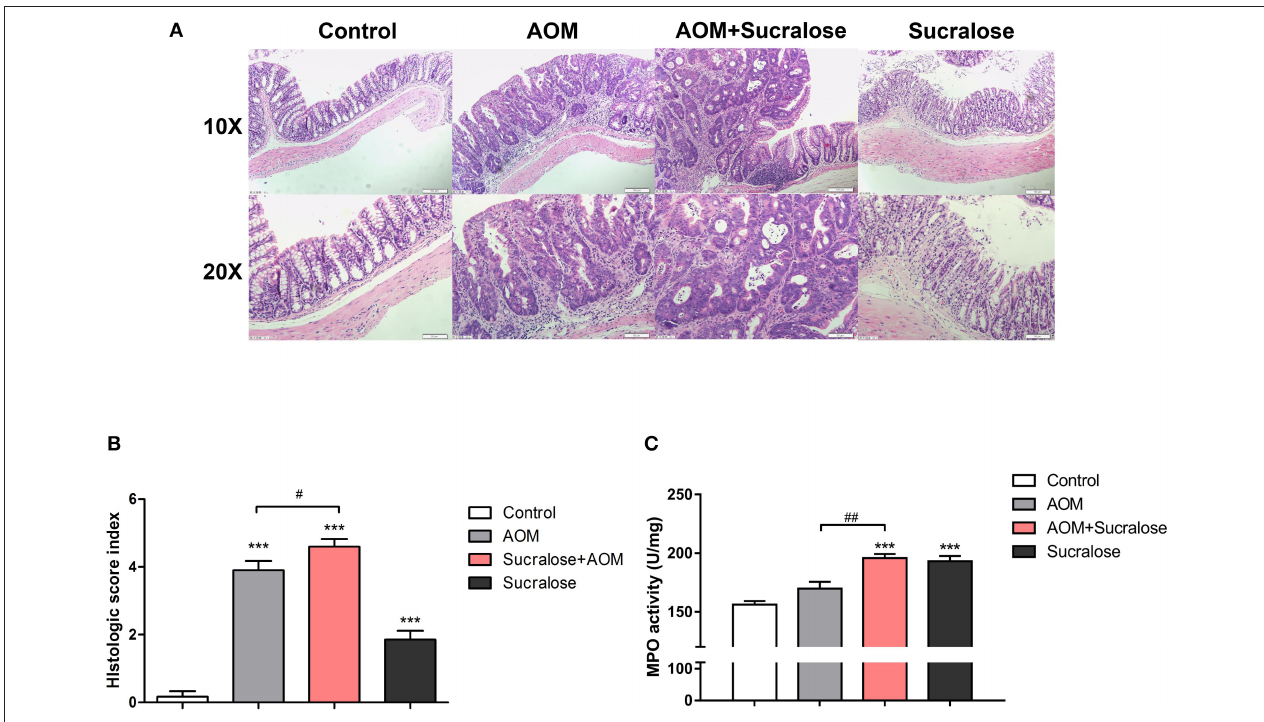
FIGURE 3 | Sucralose significantly increases colonic tissue damage in AOM/DSS colon cancer mice. (A) Light microscopy evaluation of hematoxylin and eosin (H&E)-stained sections and (B) histological score ( n = 5, scale bar = 50 µ m). (C) MPO activity of colon tissue ( n = 5). Compared with the control group: *** P < 0.001; compared with the AOM group: # P < 0.05, ## P < 0.01, n = 8.